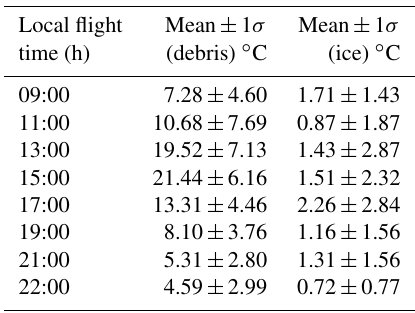
Table 2. Mean LST and standard deviation (1 σ) of the debris and ice surface